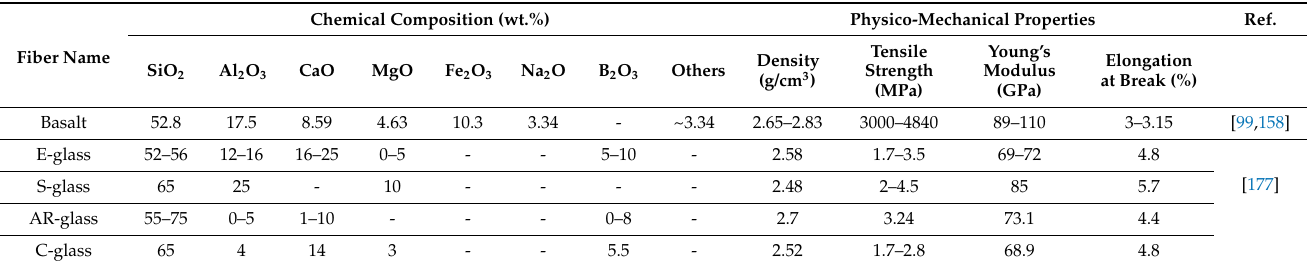
Table 4. Chemical composition and properties of inorganic